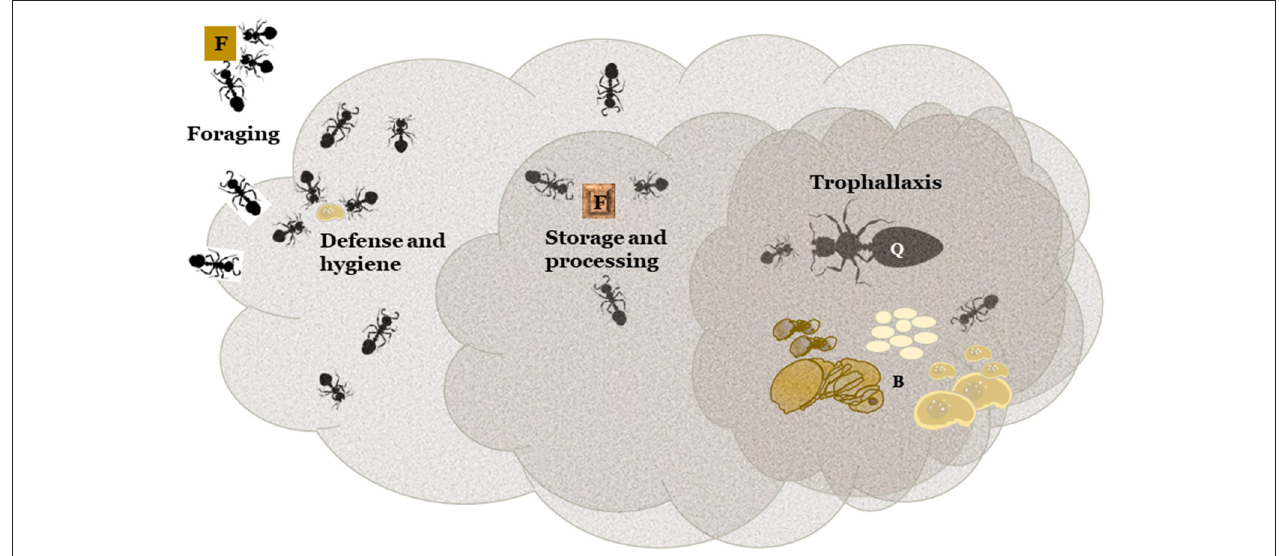
FIGURE 1 | Impediments to RNAi efficacy in ant colonies based on their social nature. Preparations of RNAi effector molecules (square labeled F for “food”) must be collected by foraging workers. Workers dedicated to defending the colony may reject contaminated food or foragers. Furthermore, worker or brood that are defective or contaminated may be discarded by worker ants functioning in a hygiene role (social immunity). Food may be stored and/or processed in sites within the nest or within workers. Modified food is represented by the square labeled F with a modified shape effect. When food is needed it is digested and converted to liquid form by larvae and distributed among juveniles, workers, and queen(s) by trophallaxis. Q, queen; B, brood.